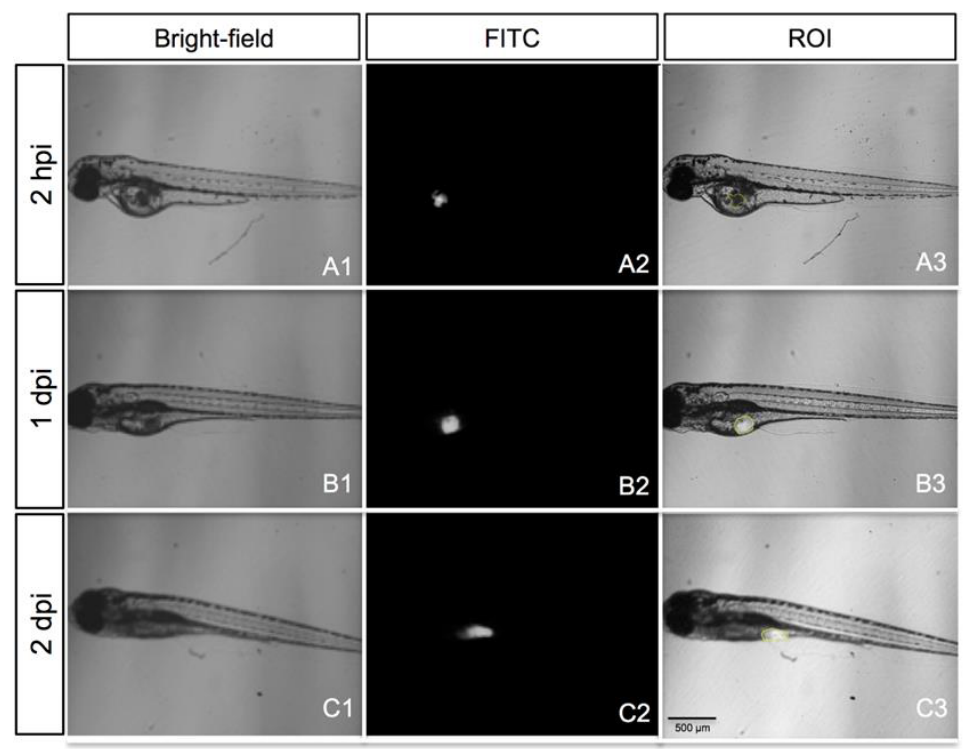
Figure 7. A representative embryo xenotransplanted with a fresh tumor specimen of gastric cancer (patient S013). Bright-field images of the grafted embryo ( A1 – C1 ), epi-fluorescence images ( A2 – C2 ) and overlay ( A3 – C3 ), showing the region of interest (ROI; yellow line). All images are oriented so that the rostral end is on the left and dorsal end is on the top.